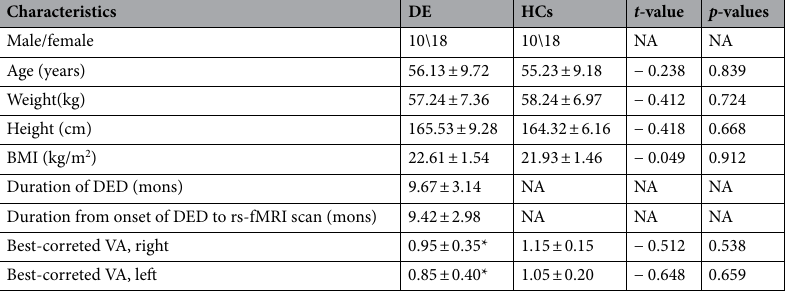
Table 1. Clinical characteristics of patients between DE and HC groups. Independent t-tests comparing the two groups (* P < 0.05) represented statistically significant differences). DE dry eye, HCs healthy controls, NA not applicable, BMI body mass index, rs-fMRI resting-state functional magnetic resonance, VA visual